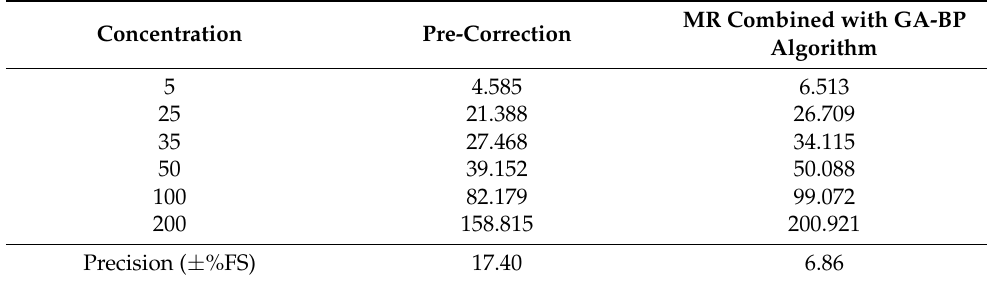
Table 6. Precision of flow correction